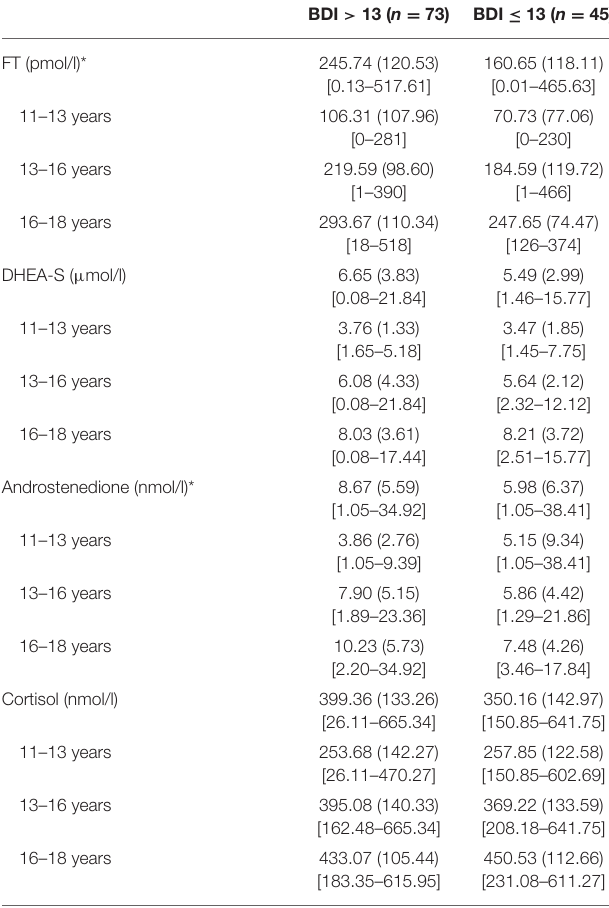
TABLE 2B | Selected hormone